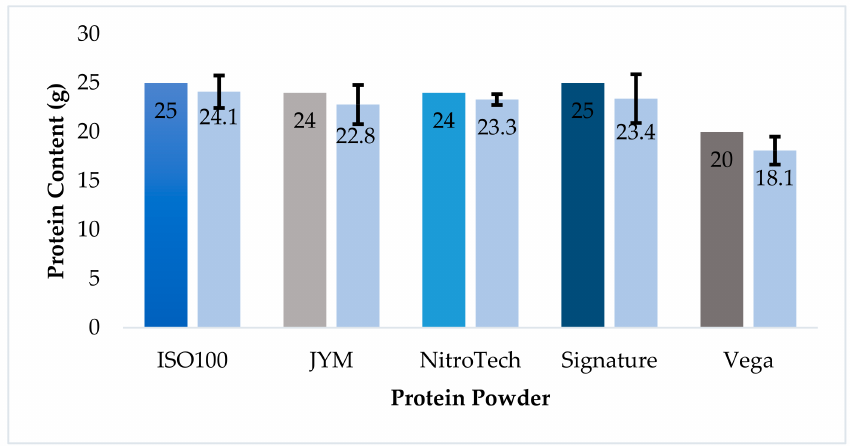
Figure 3. Bar graph comparing protein content as stated on product labels to experimental data from KM measurement. Standard deviation is shown for each product, with error bars based on a sampling size of 14 measurements